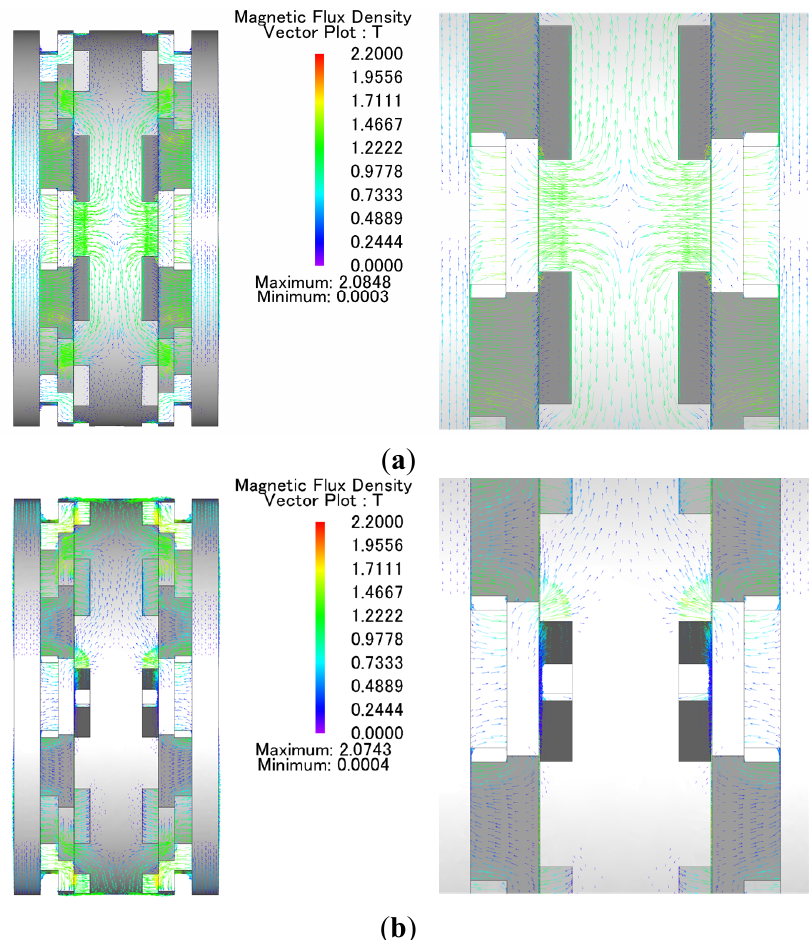
Figure 6. No-load magnetic field distributions: ( a ) Position 1; and ( b ) Position 2.